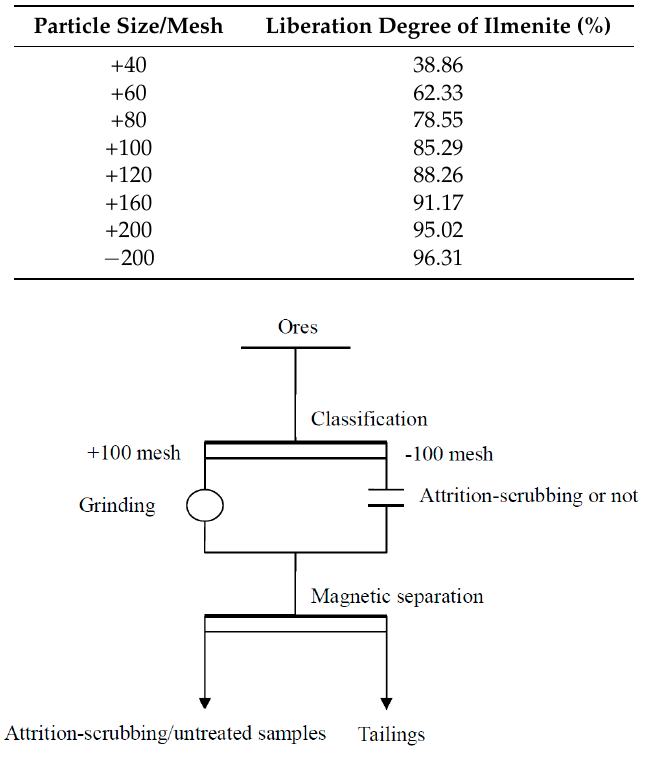
Figure 1. The principal flowchart of pre-enrichment for samples after one high-intensity magnetic